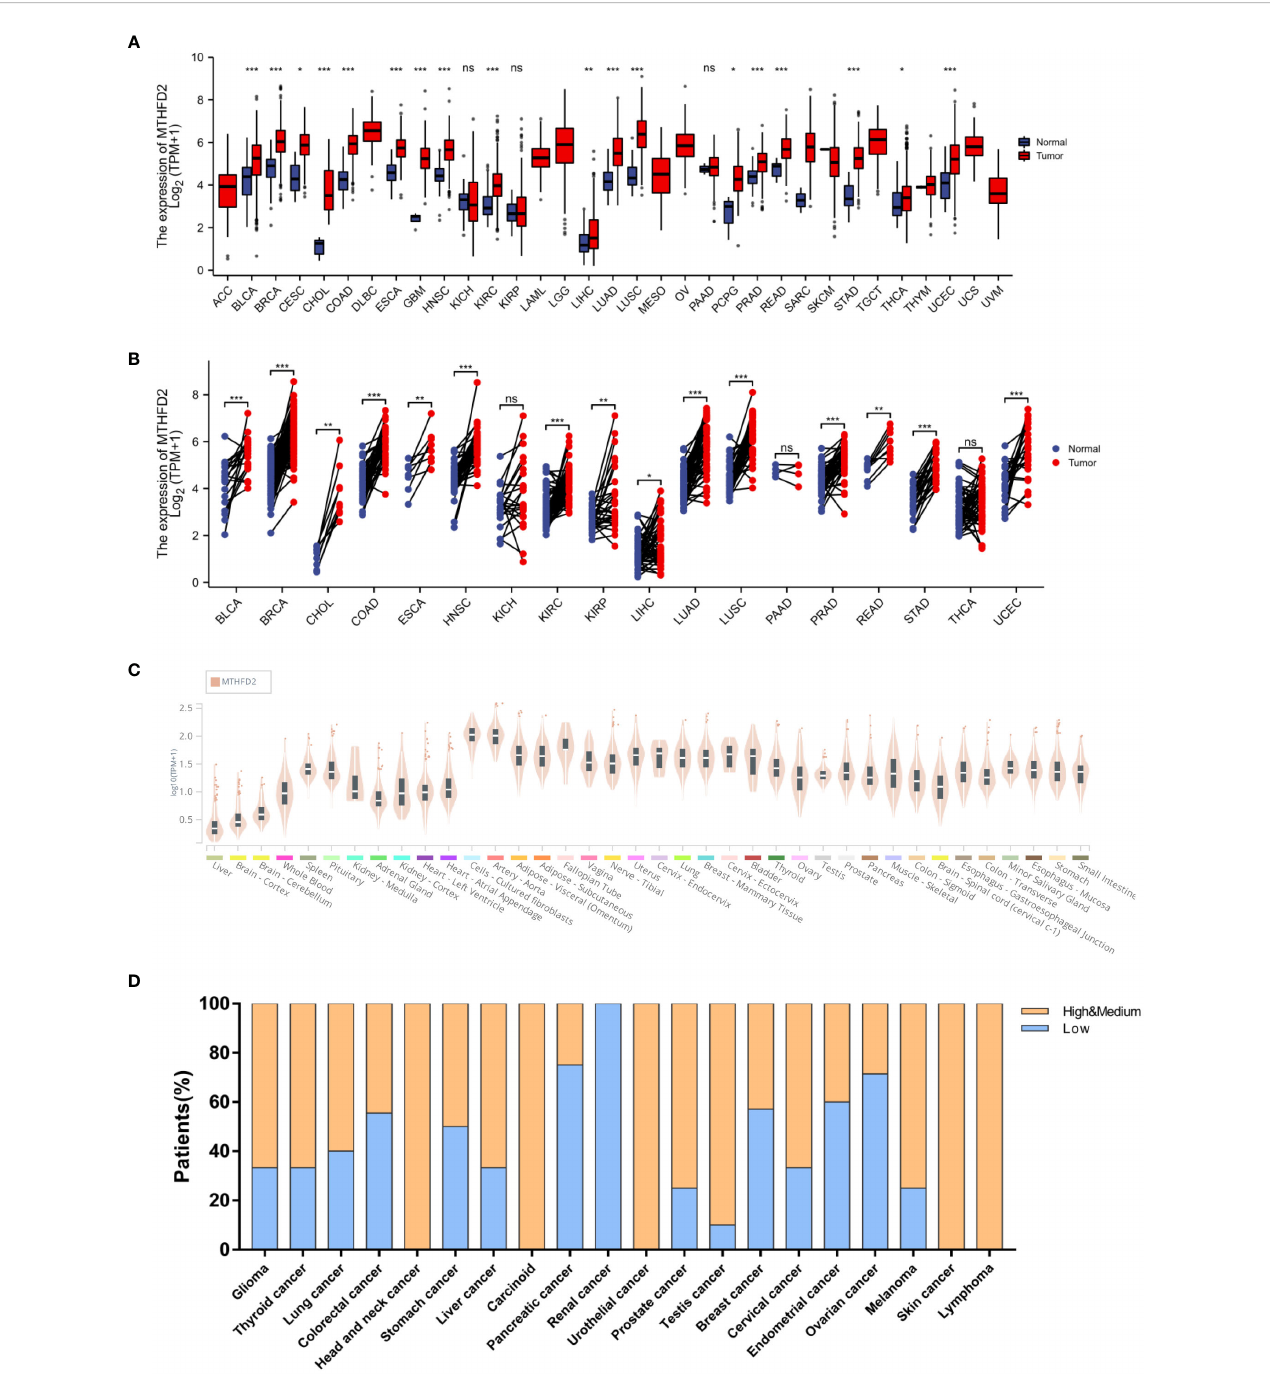
FIGURE 1 MTHFD2 expression in various normal and tumor tissues. Differential MTHFD2 mRNA expression levels in various normal tissues and tumors. (A) On unpaired sample analysis and (B) On paired sample analysis. Red represents tumor tissues and blue represents normal tissues. (C) MTHFD2 mRNA expression levels in normal tissues. (D) Protein expression pattern of MTHFD2 in various cancers. Orange indicates high or moderate MTHFD2 protein expression, while blue indicates low MTHFD2 protein expression. ns: p ≥ 0.05, * p <0.05, ** p <0.01, *** p <0.001, and **** p